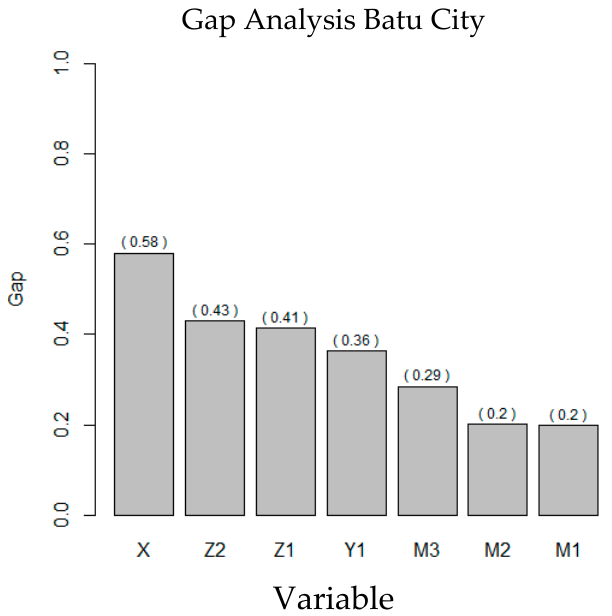
Figure A1. Bar Diagram of Gap Analysis of Batu City.